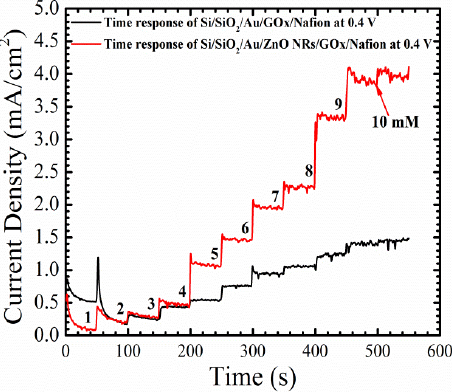
Figure 8. Time response of the fabricated electrochemical sensor Si/SiO 2 /Au/ZnO NRs/GO x /Nafion and (baseline) Si/SiO 2 /Au/GO x /Nafion at 0.4 V.